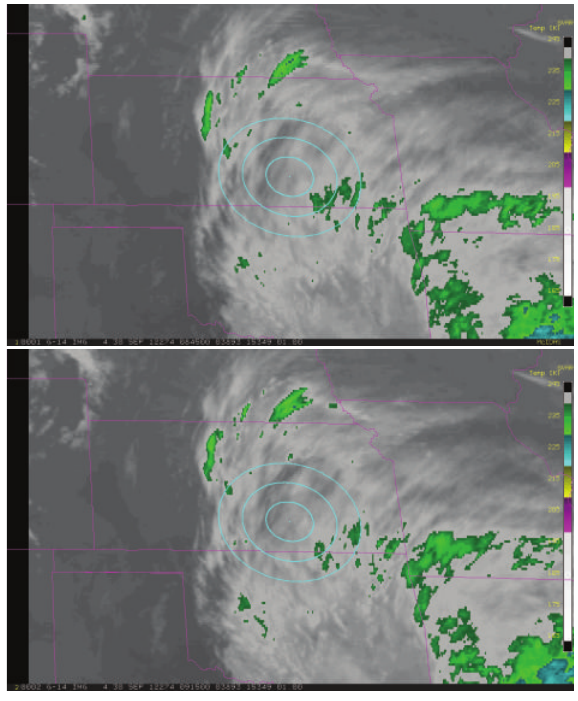
Figure 7: Infrared images from GOES-14 at 084500 UTC (upper panel) and 091500 UTC (lower panel) on 30 September 2012 over Kansas State and its neighboring states. The state boundaries are plotted in purple. The three cyan circles plot the 50, 100, and 200 km range rings cocentered at the KICT radar site (shown by the cyan dot). The dark areas show relatively warm brightness temperature remotely sensed from the ground, indicating clear sky over each dark area. The green areas highlight cloud tops colder than 240 ∘ K ( ≈− 30 ∘ C around 7 km